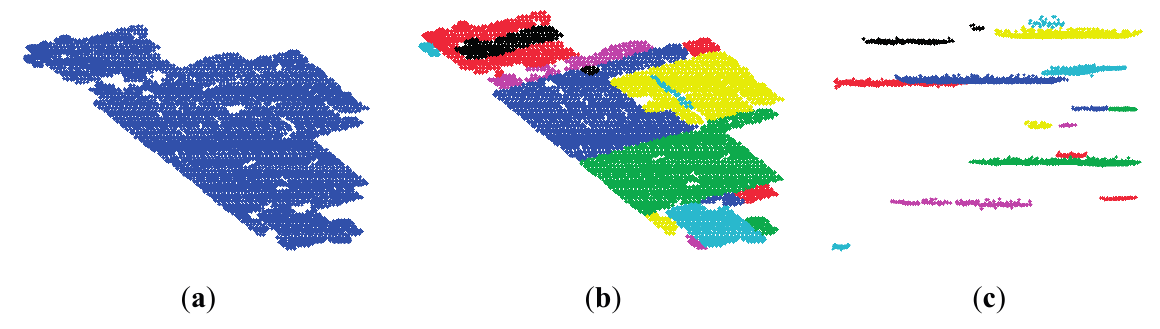
Figure 4. Example of roof patch segmentation with height jumps. ( a ) ALS building points; ( b ) detected roof patches shown in different colors; ( c ) roof patches at different heights.